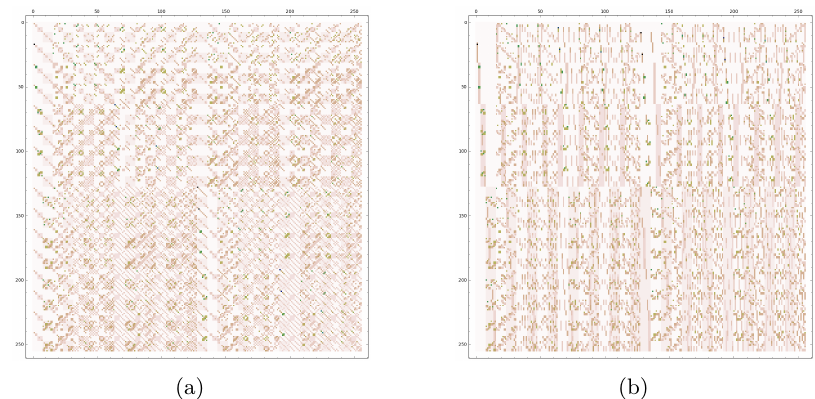
Figure 5: The Jackson Pollock representation of the LATs of 𝒫 and 𝒫 composed with a branch swap.